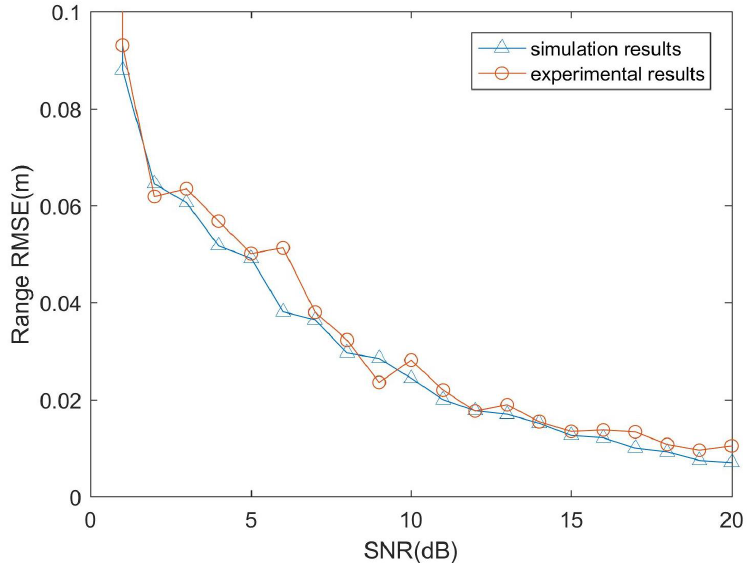
Figure 10. Simulation and experimental results of the ranging RMSE varying with the